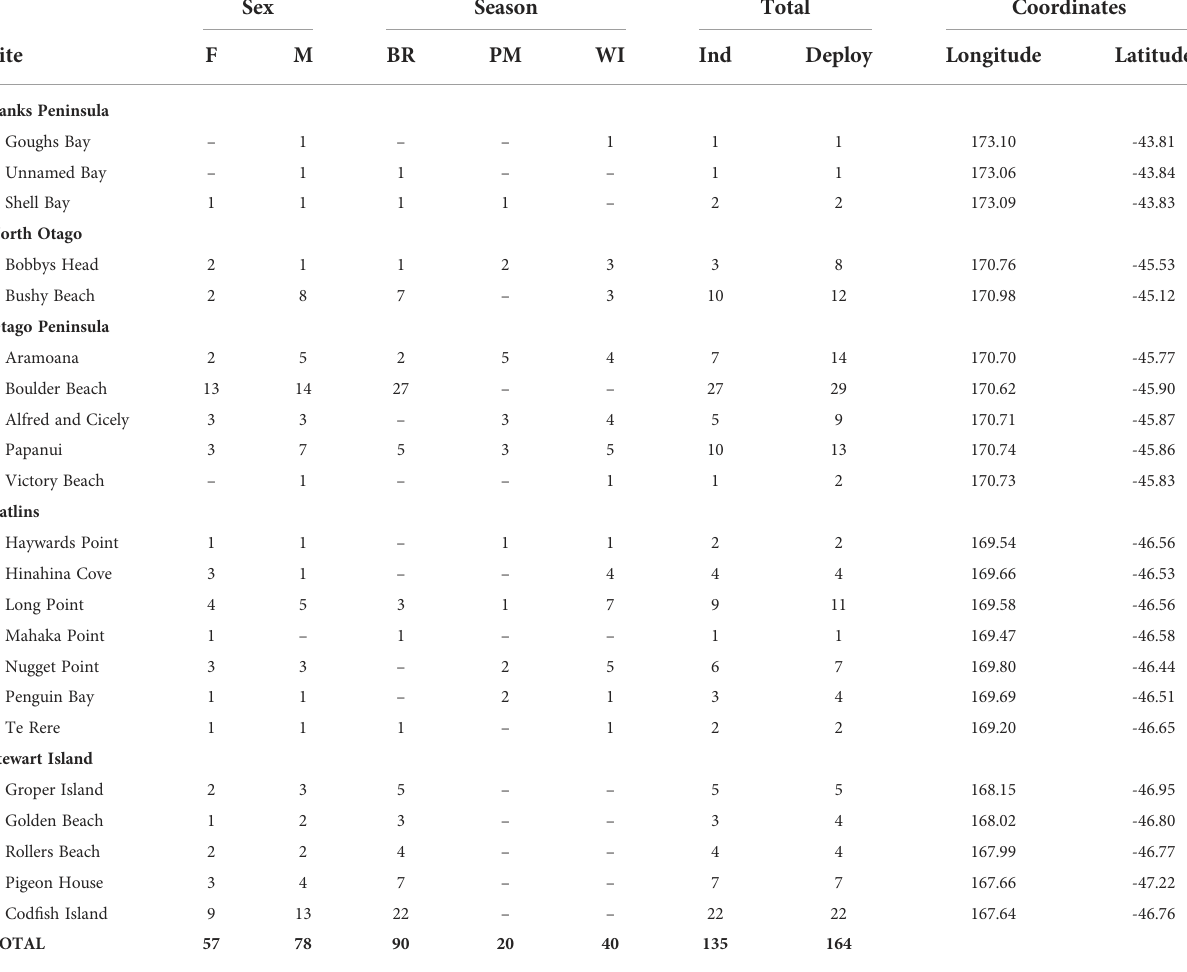
TABLE 1 Sample sizes of GPS-tracked, adult yellow-eyed penguins from each breeding colony and geographic region according to sex (female-F, male-M) and season (breeding-BR, premoult-PM,